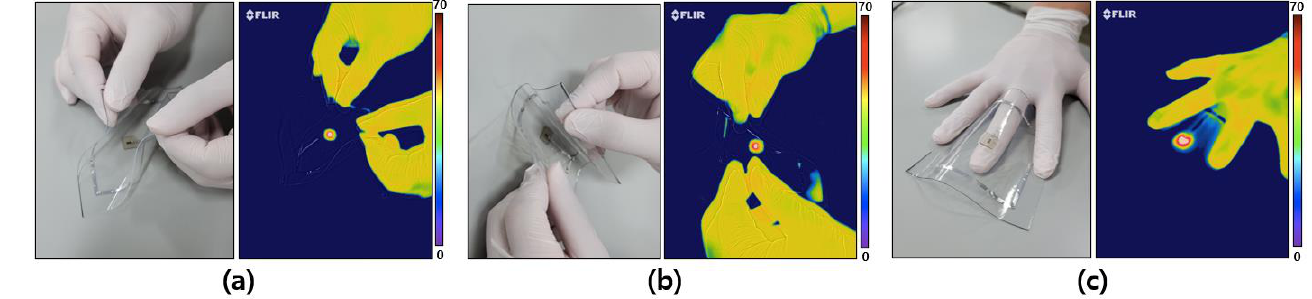
Figure 6. Wireless operation of a micro-heater with various modifications, such as bending in the diagonal direction ( a ), the horizontal direction ( b ), and as if putting it between fingers ( c ).